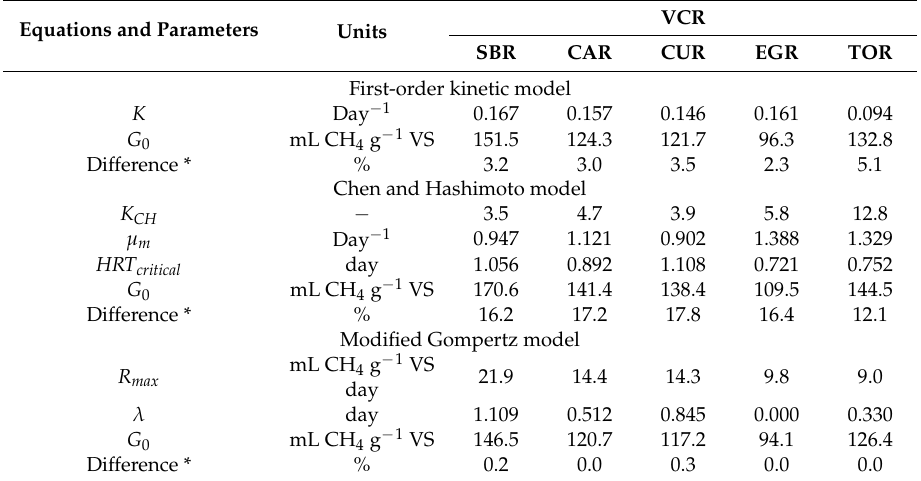
Table 4. Summary of results of kinetic study using three different models. Equations and